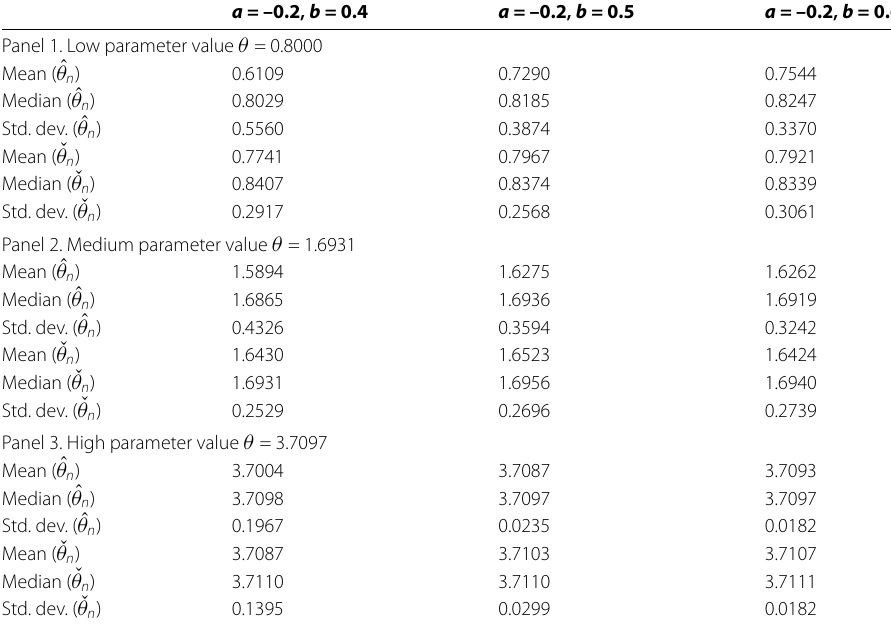
Table 1 The means, medians, and standard deviations of estimators a = –0.2 , b = 0.4 a = –0.2 , b = 0.5 a = –0.2 , b =